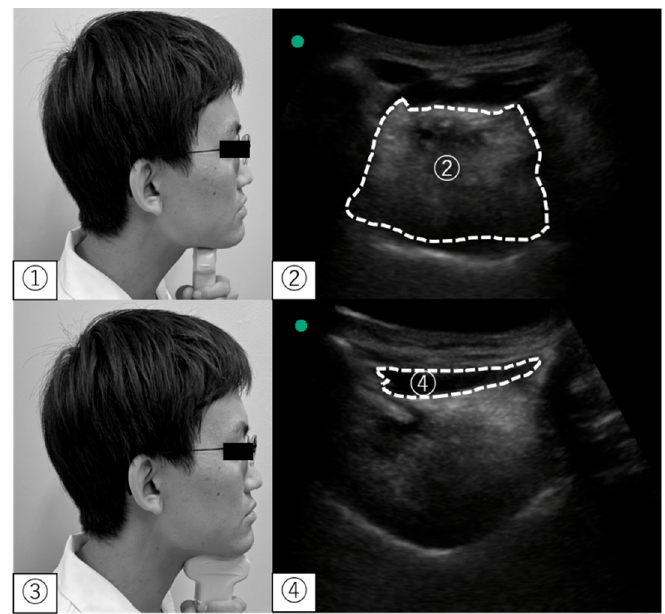
Figure 2. Jaw-opening force measurement (jaw-opening stenometer). ① Head-encircling belt; ② Two straps to secure the mandible to the head-encircling belt; ③ Chin cap; ④ Dynamometer to assess jaw-opening strength.